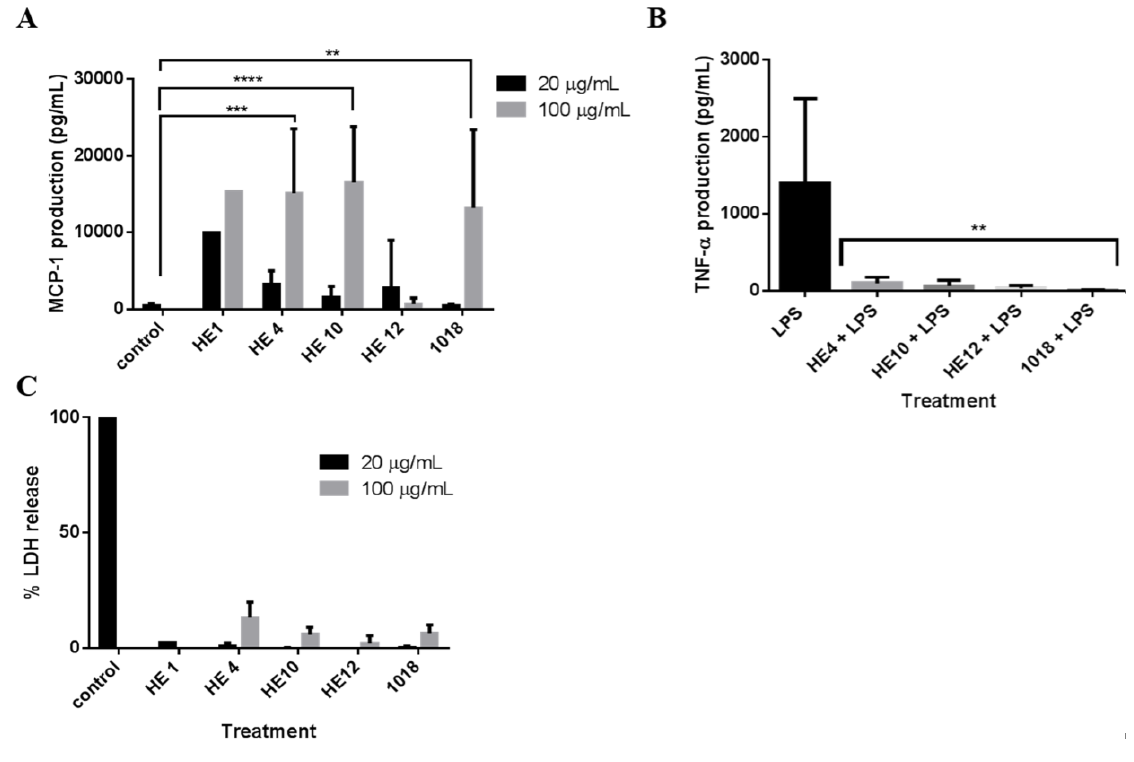
Figure 4. Immunomodulatory activity and cytotoxicity of peptide 1018 and its derivatives HE1, HE4, HE10, HE12. ( A ) Human peripheral blood mononuclear cells were subjected to 20 µg/mL and 100 µg/mL of HE1, HE4, HE10, HE12, and 1018 for 24 h. Monocyte chemotactic protein-1 (MCP-1) production was assessed using sandwich enzyme linked immunosorbent assay (ELISA). The level of MCP-1 induction was similar for HE1, HE4, HE10, and 1018 at 100 µg/mL; ( B ) LPS (20 ng/mL) was co-administered with 20 µg/mL of each of the aforementioned peptides for 24 h. The tumor necrosis factor-alpha (TNF-α) production in response to both stimulants was assessed using enzyme linked immunosorbent assay (ELISA) and compared to lipopolysaccharides (LPS) alone. (The peptides themselves did not induce any significant TNF-α production). In both A and B, statistical significance was assessed using one-way ANOVA ( ** , p < 0.01; *** , p < 0.001); ( C ) Peptide 1018 and its derivatives were not cytotoxic. Lactate dehydrogenase release from peripheral blood mononuclear cells (PBMCs) was measured to assess the toxicity of 20 µg/mL and 100 µg/mL of 1018 and its